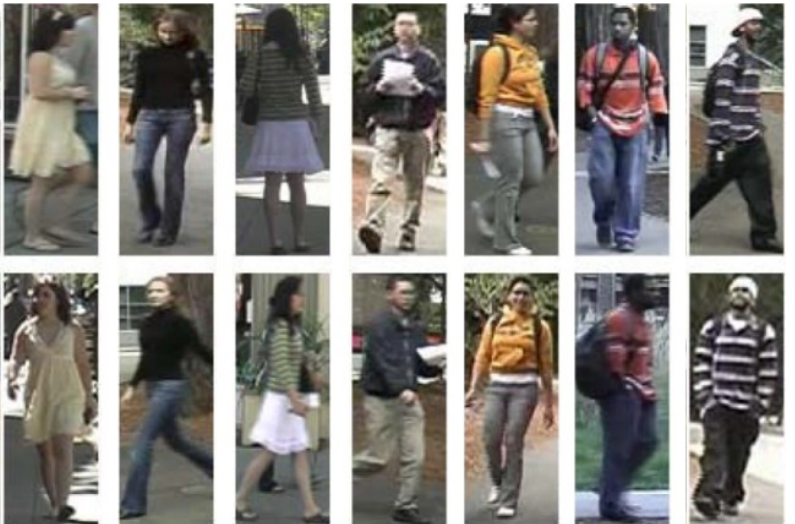
Figure 2. Pedestrian examples from Viewpoint Invariant Pedestrian Recognition (VIPeR) dataset. Adapted from [22]. Each column shows the same person but colors look different in other lighting conditions as in the second and last columns. The appearance-based re-identification only works with assumptions where a person shown in a camera appears in another camera in a short period of time with similar lighting